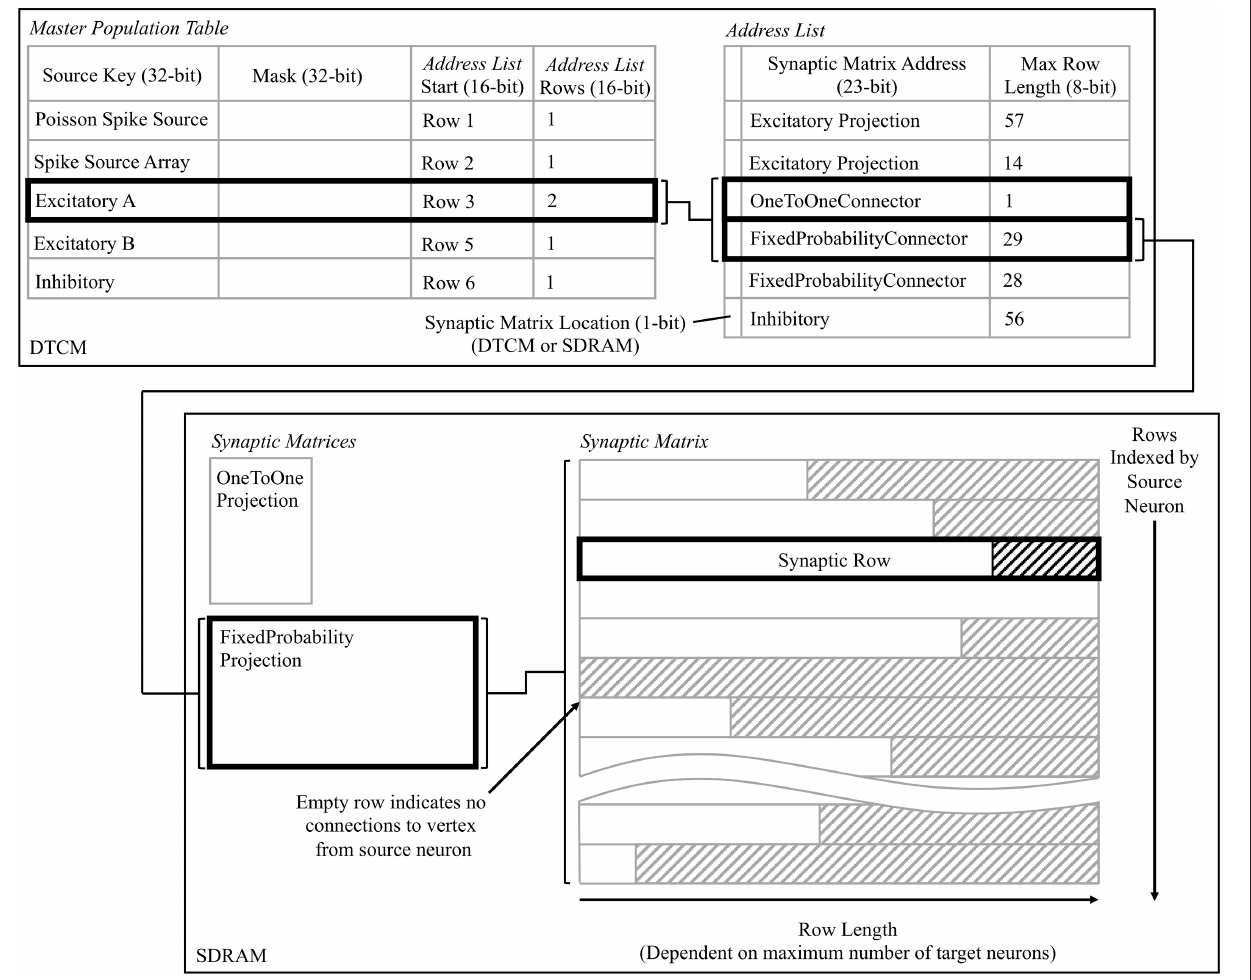
FIGURE 7 | Data structures for processing incoming spikes: Master Population Table , Address List , and Synaptic Matrix ; shown from the perspective of the core simulating the Excitatory A population in Figure 3B . The path in bold represents that taken when a packet is received by Excitatory A, originating from itself, and hence two projections must be